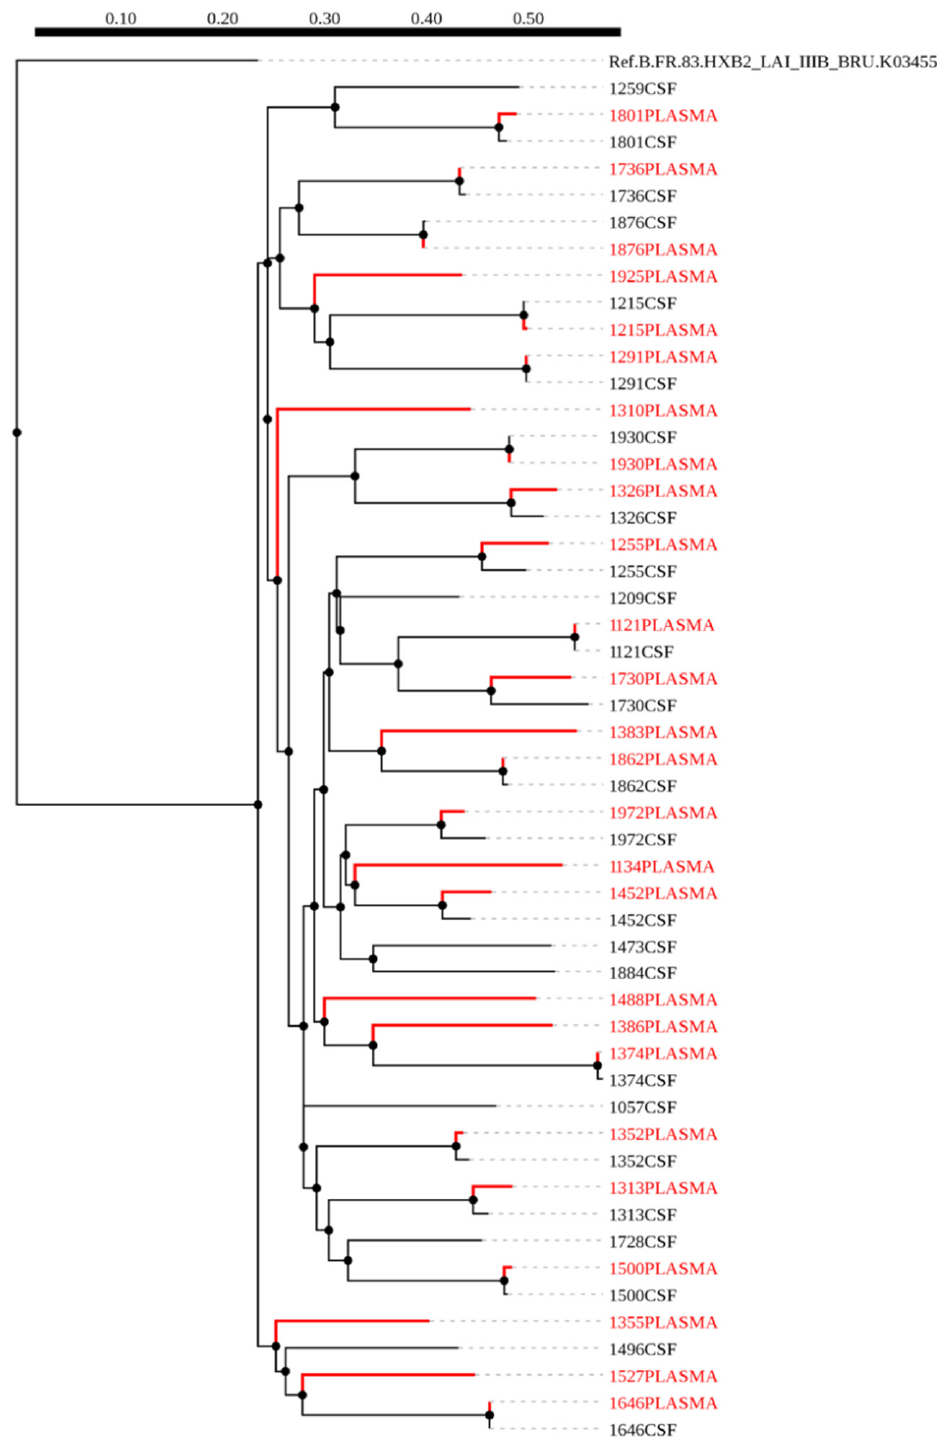
Figure 1. A maximum likelihood phylogenetic tree of HIV-1 env sequences from CSF and plasma samples of individuals with HIV-associated cryptococcal meningitis (CM). The distance scale is shown by the numbers at the top of the tree that represents the number of nucleotide substitutions per site. The branch length indicates genetic change.